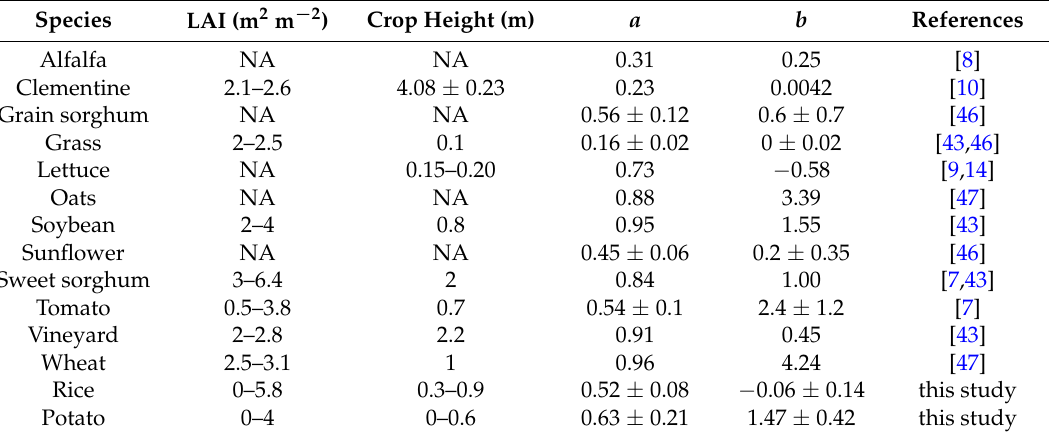
Table 1. Calibration coefficients of the PM-KP